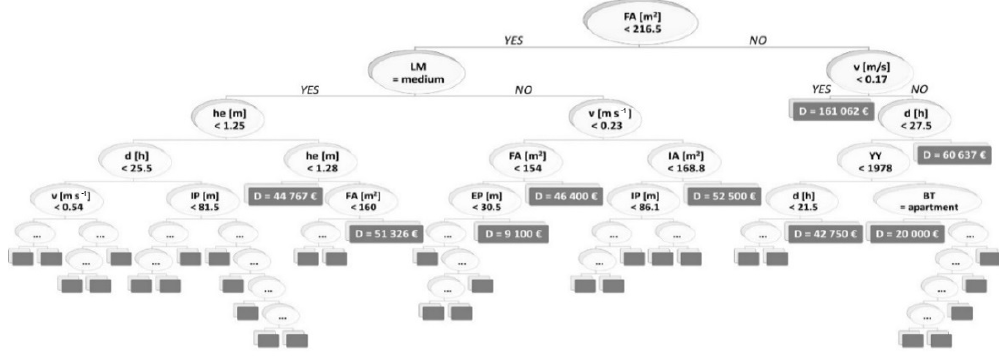
Figure 3. Example of one of the regression trees produced by the random forest